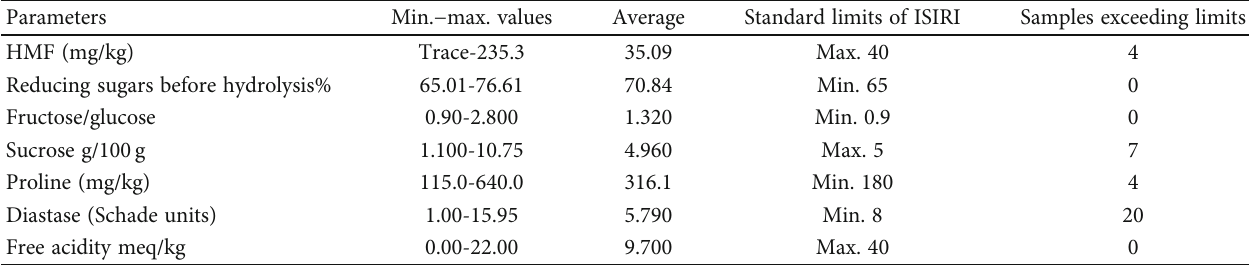
Table 1: The physicochemical parameters of Iranian honey samples ( number of tested samples = 25